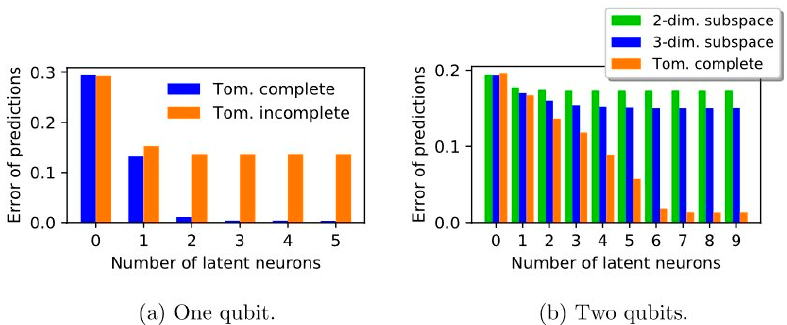
Figure 8. Quantum tomography. SciNet is given tomographic data for one or two qubits and an operational description of a measurement as a question input and has to predict the probability of outcomes for this measurement. It was trained with both tomographically complete and incomplete sets of measurements, and found that, given tomographically complete data, SciNet could be used to find the minimal number of parameters needed to describe a quantum state (two parameters for one qubit and six parameters for two qubits) [51].